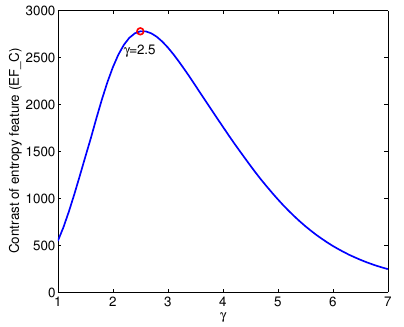
Figure 9. Contrast of entropy feature versus γ .